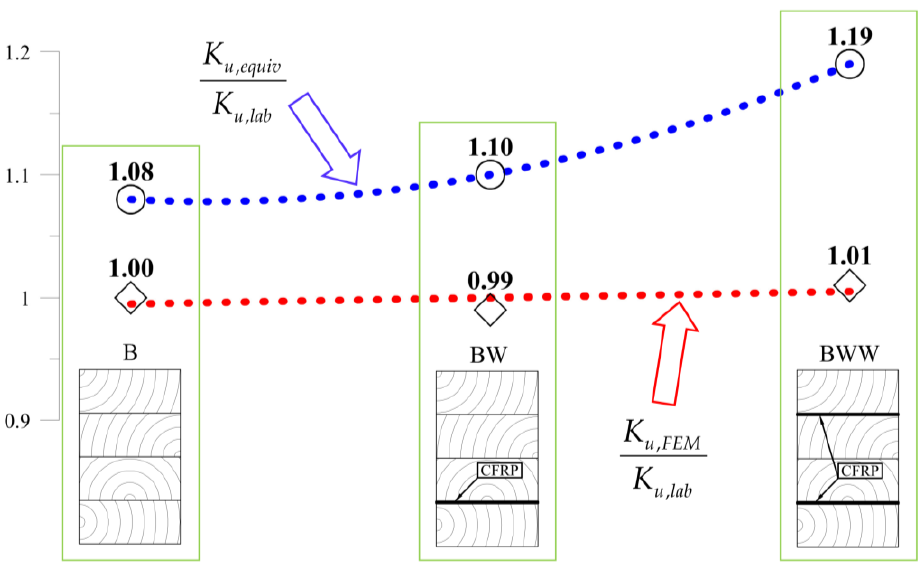
Figure 28. Comparison of the results for FE and equivalent cross-sectional model.